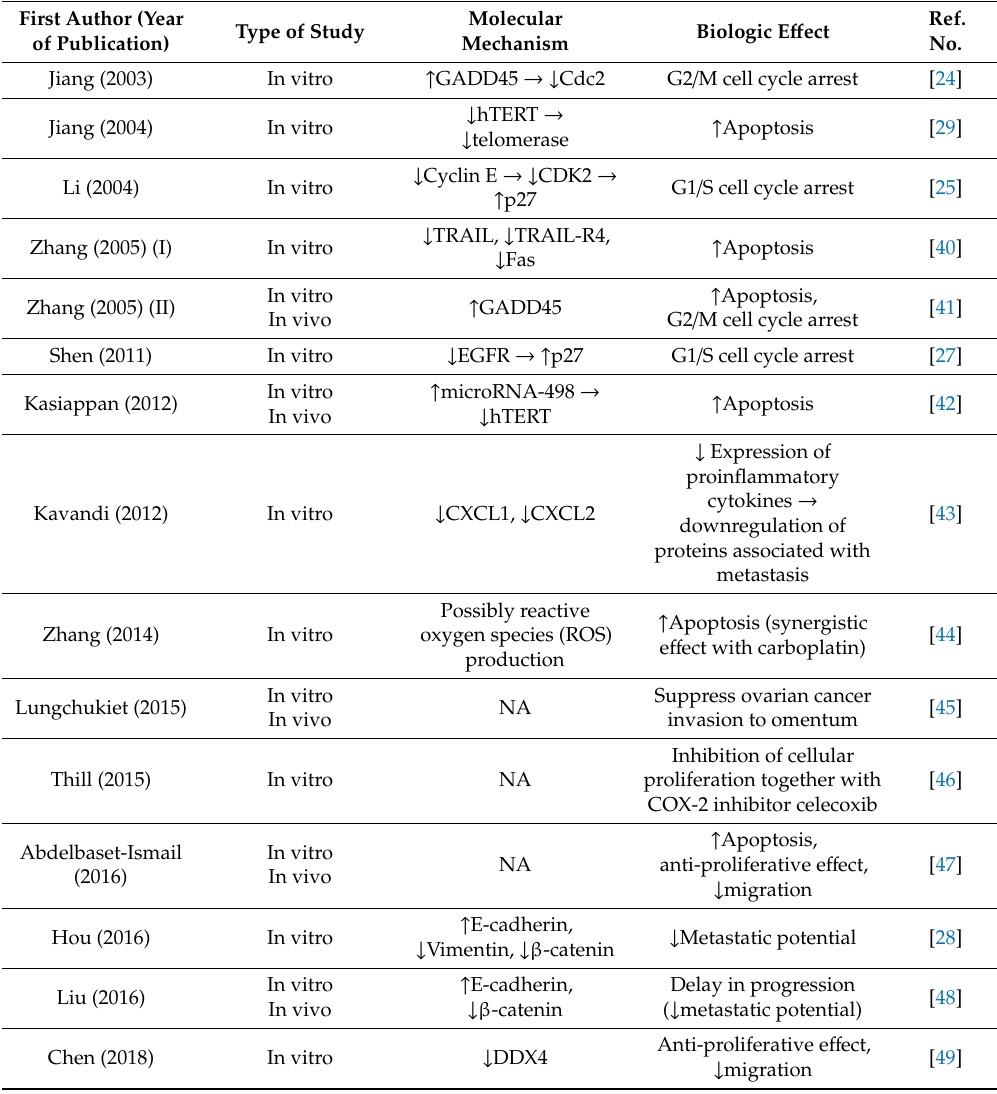
Table 1. Description of studies on the e ff ects of calcitriol and its analogues specifically on ovarian cancer cell cycle, apoptosis, invasion, and inflammatory process. See text for details. NA: Not